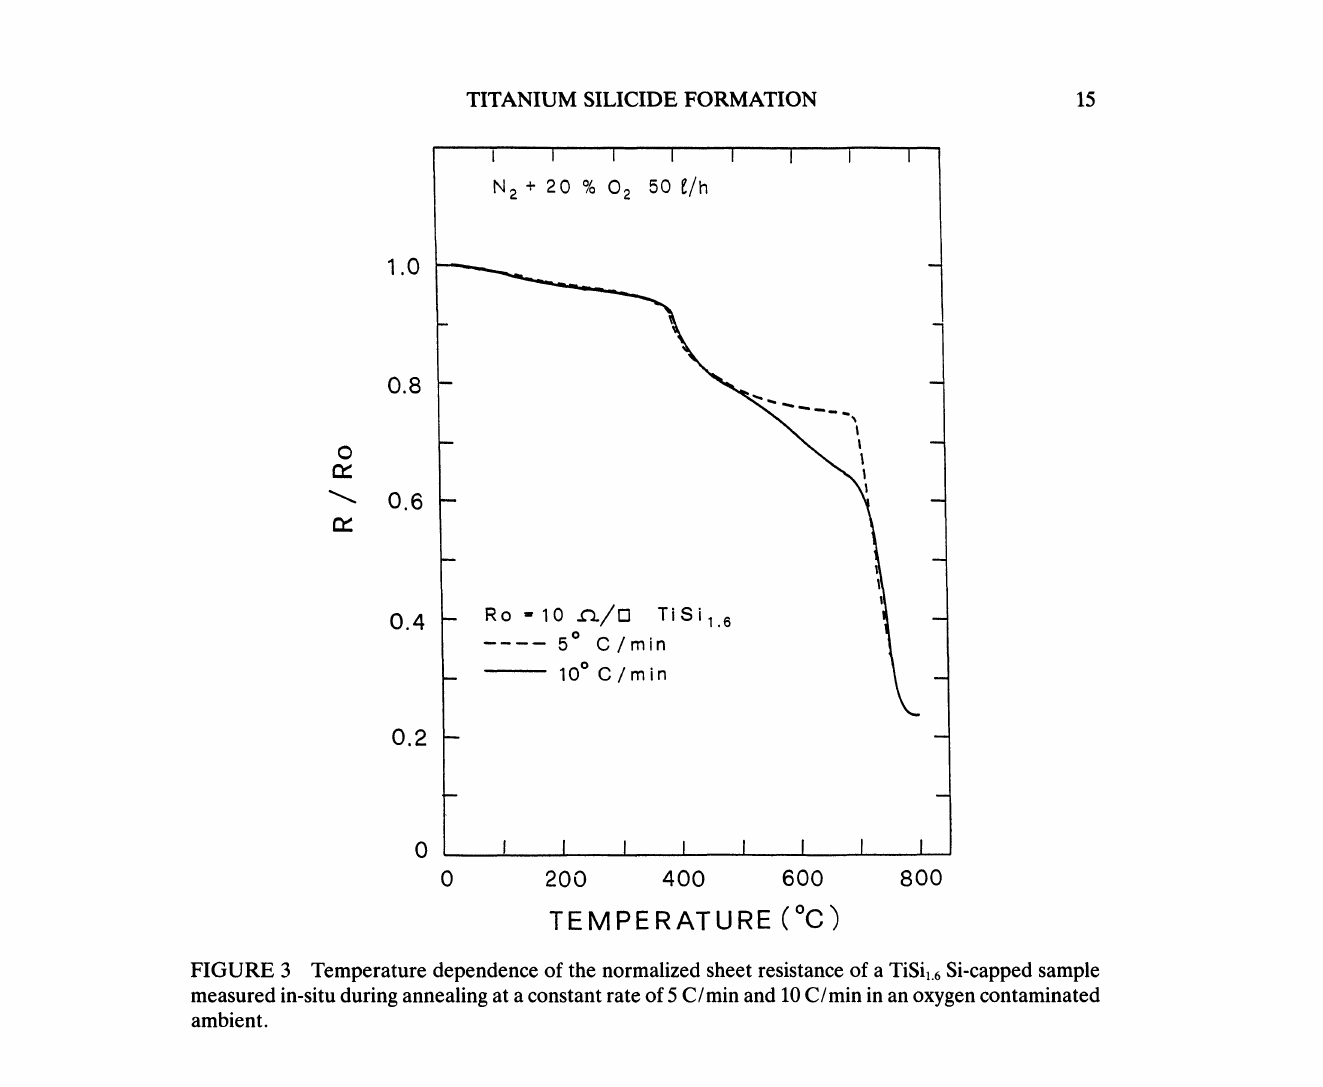
FIGURE 3 Temperature dependence of the normalized sheet resistance of a TiSil.6 Si-capped sample measured in-situ during annealing at a constant rate of 5 C/min and 10 C/min in an oxygen contaminated